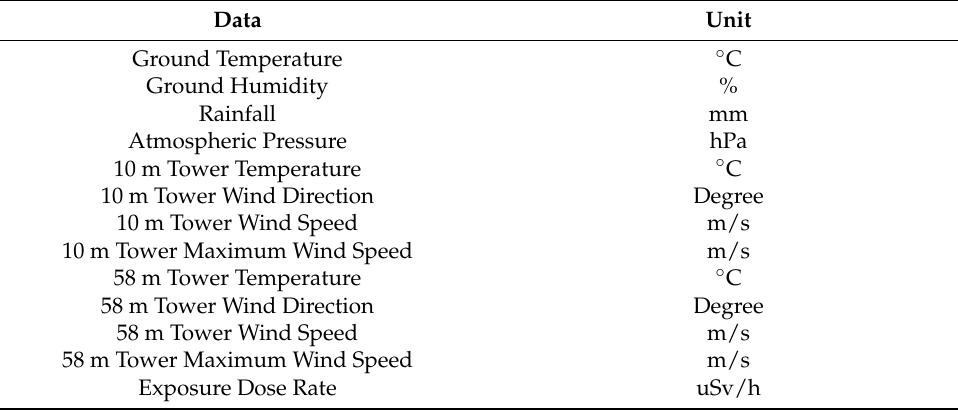
Table 1. Environmental parameters in the experimental